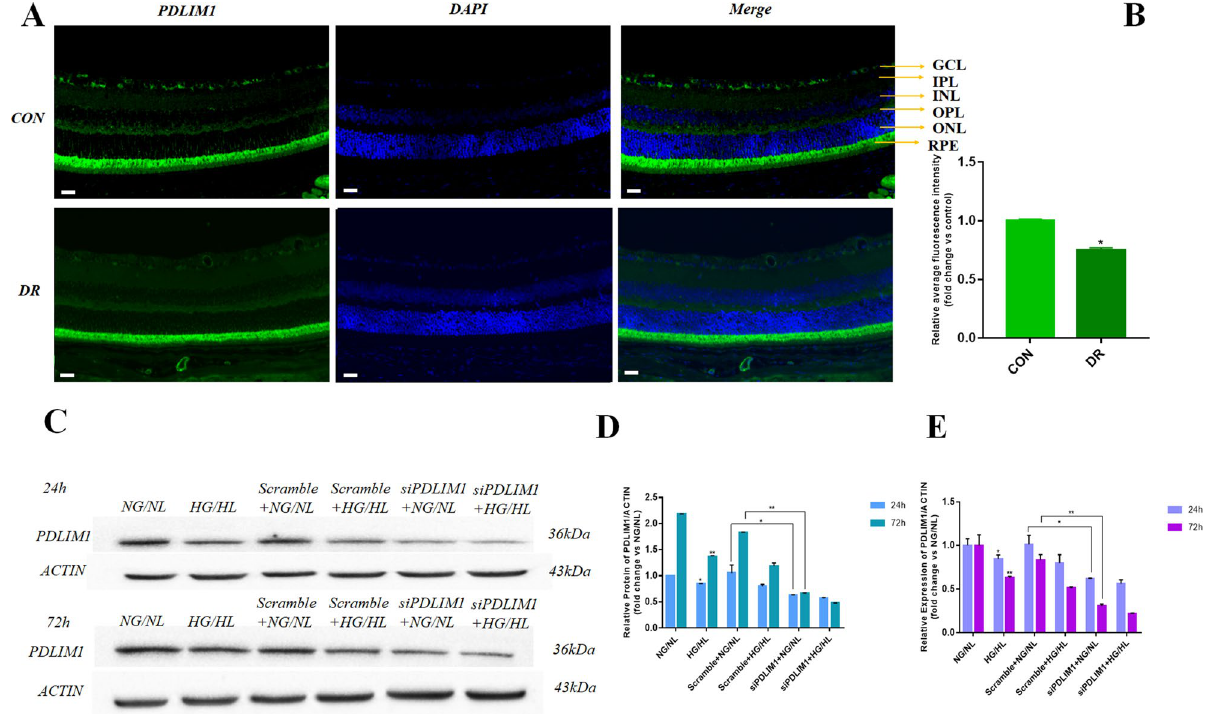
Figure 1. The expression of PDLIM1 in mouse retina and retinal capillary endothelial cells (RCECs). ( A ) Immunofluorescence staining shows that PDLIM1 is mainly expressed in the retinal pigment epithelium (RPE). Scale bar: 100 μm. ( B ) Semi-quantitative analysis showed that PDLIM1 expression decreased in DR mice compared to control. ( C ) Representative immunoblots show that the protein expression of PDLIM1 decreased after HG/HL treatment. ( D ) PDLIM1 decreased at 24 h in HG/HL (P < 0.05), and the trend was more evident after 72 h (P < 0.01) compared with those in NG/NL. ( E ) The mRNA expression of PDLIM1 downregulated at layer, INL: inner nuclear layer, OPL: outer plexiform layer, ONL: outer nuclear layer, RPE: retinal pigment